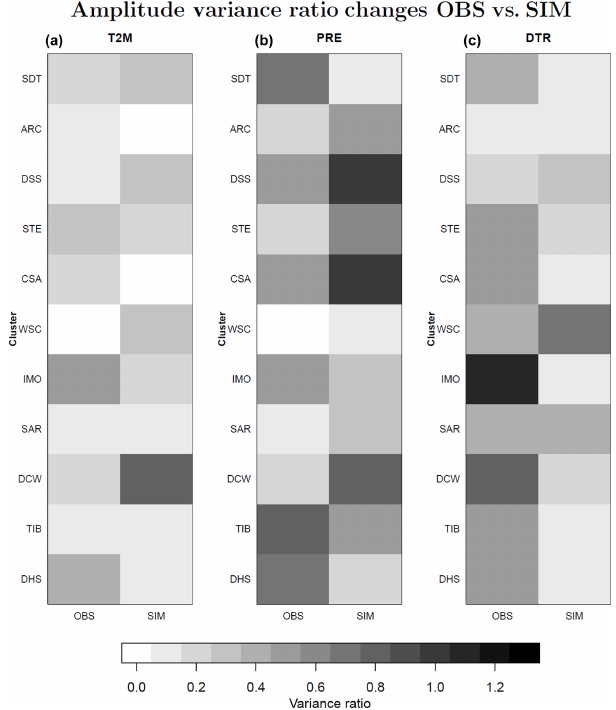
Figure 11. Absolute differences in variance ratio. The left column of each panel shows the absolute differences in the variance ratio of the same experiment, a, when considering different observational data sets. The right column of each panel shows the range of abso- lute differences between the variance ratio of experiment a and that of the other experiments, from b to q, when using a single observa- tional data set for each variable. From left to right, the panels respec- tively present the results of the comparison for near-surface tem- perature (T2M), precipitation (PRE) and diurnal temperature range (DTR). The different rows show the results obtained for each of the